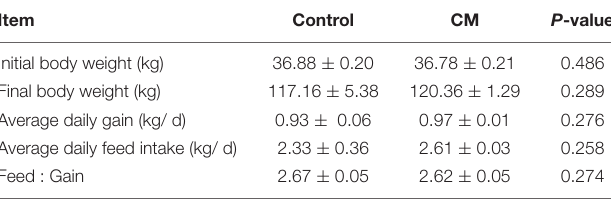
TABLE 4 | Effect of CM on growth performance of pigs.